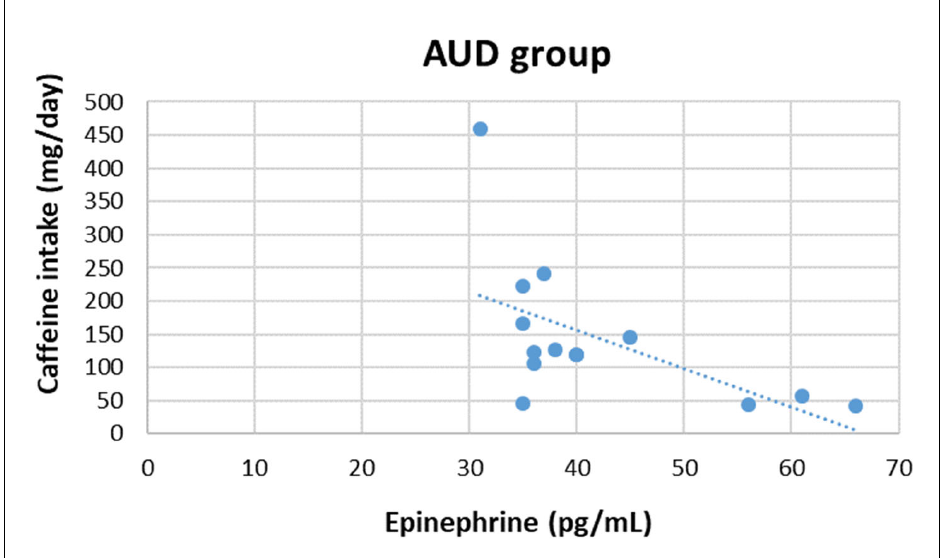
Figure 2. Correlation between plasma epinephrine concentrations and daily caffeine intake in AUD group.